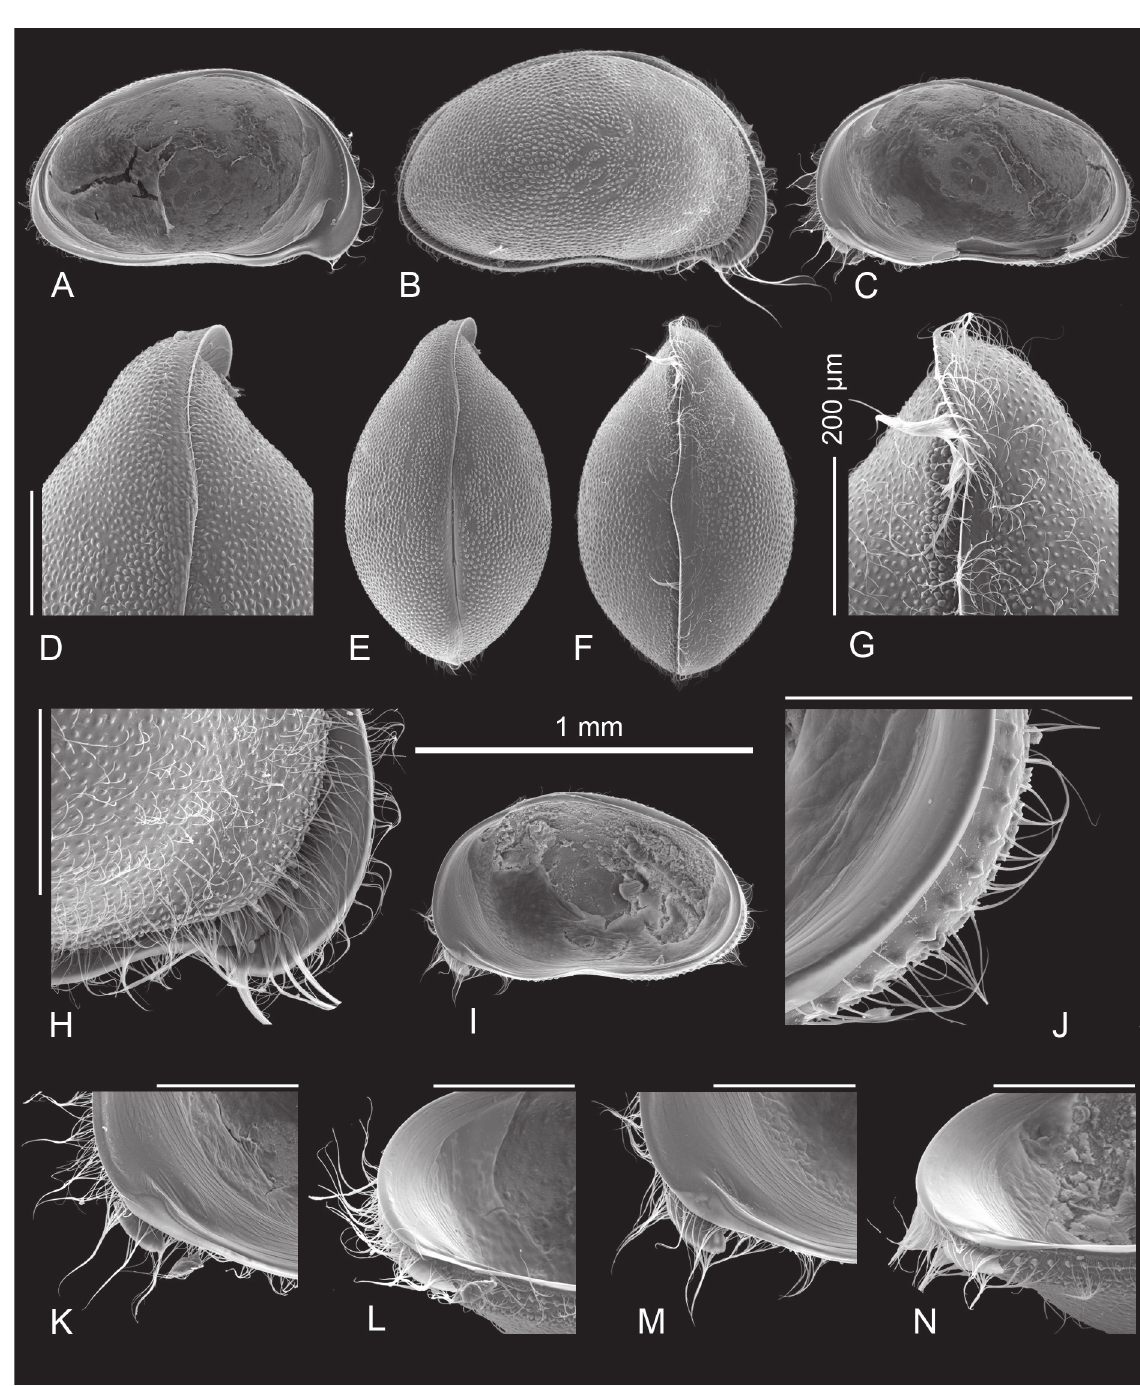
Fig. 9. Bennelongia muggon sp. nov. (all ♀, from type locality: Lake Muggon, Murchison/Gascoyne, WA). A . LVi (holotype, WAMC55632). B . CpRL (WAMC55635). C . RVi (WAMC55632). D . cpD, detail anterior margin (WAMC55634). E . CpD (WAMC55634). F . CpV (WAMC55636). G . cpV, detail anterior margin (WAMC55636). H . CpRL, detail anterior margin (WAMC55635). I . RVi (WAMC55633). J . RVi, detail posterior margin (WAMC55633). K . RVi, detail anterior margin (WAMC55632). L . rVi, tilted, detail anterior margin (WAMC55632). M . RVi, detail anterior margin (WAMC55633). N . rVi, tilted, detail anterior margin (WAMC55633). Scales = 1 mm for A–C, E–F, I; 200 µm for D, G–H,